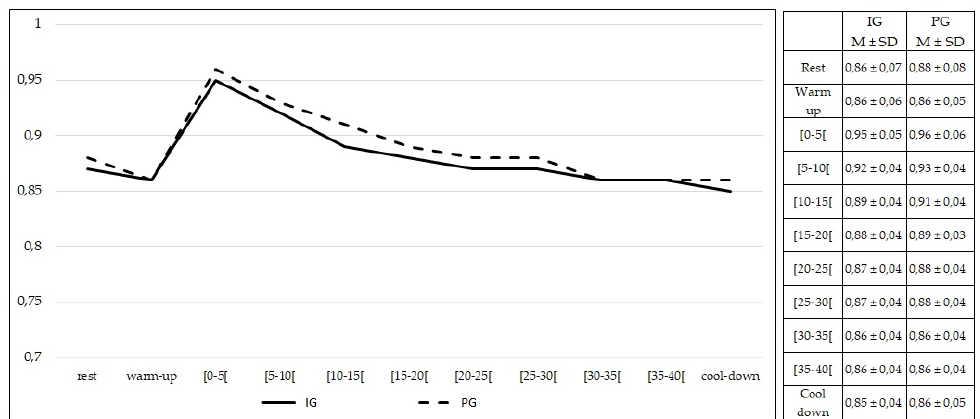
Figure 10. Respiratory exchange ratio values during rest, exercise, and cool-down in intervention group and placebo group. Data are expressed as mean ± standard deviation. IG: intervention group; PG: placebo group.